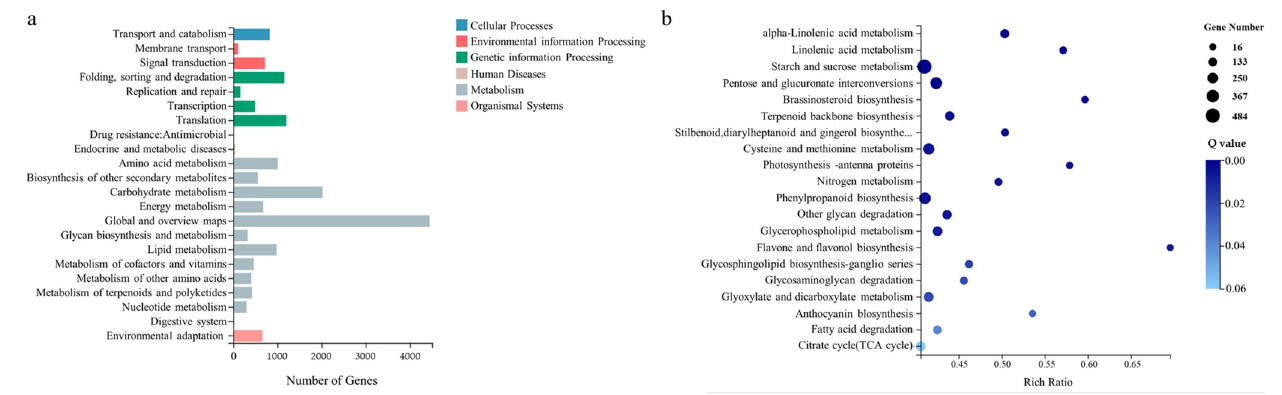
Figure 7. KEGG analysis of DEGs. ( a ) KEGG pathway classification of DEGs. ( b ) KEGG pathway enrichment of DEGs.